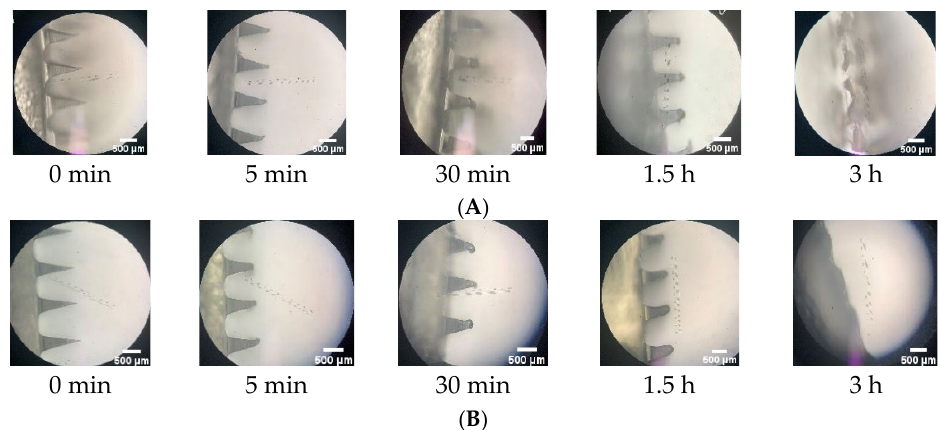
Figure 11. Microscopy observation for in-skin dissolution studies containing ketoprofen nanosuspension in DMN formulations ( A ) F4-MN NS (5% PVA + 10% PVP) and ( B ) F5-MN NS (5% PVA + 15% PVP) (scale bar: 500 µm).